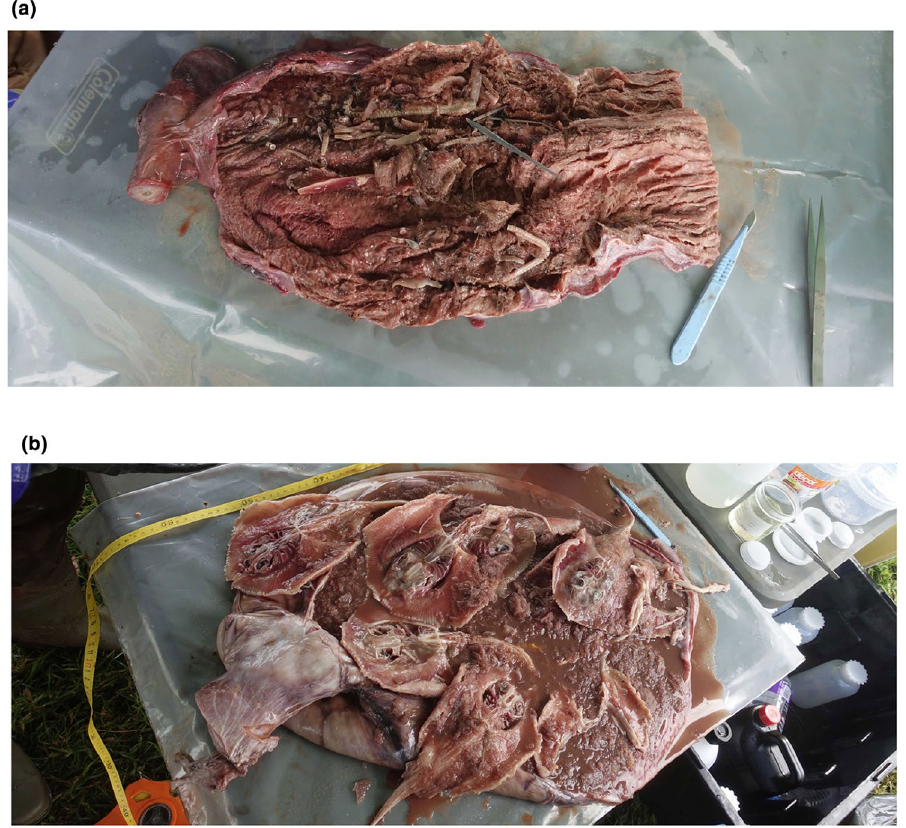
Figure 2. Photos of ( a ) jaw bones and ( b ) Urolophus sp. in the stomachs of two Sphyrna